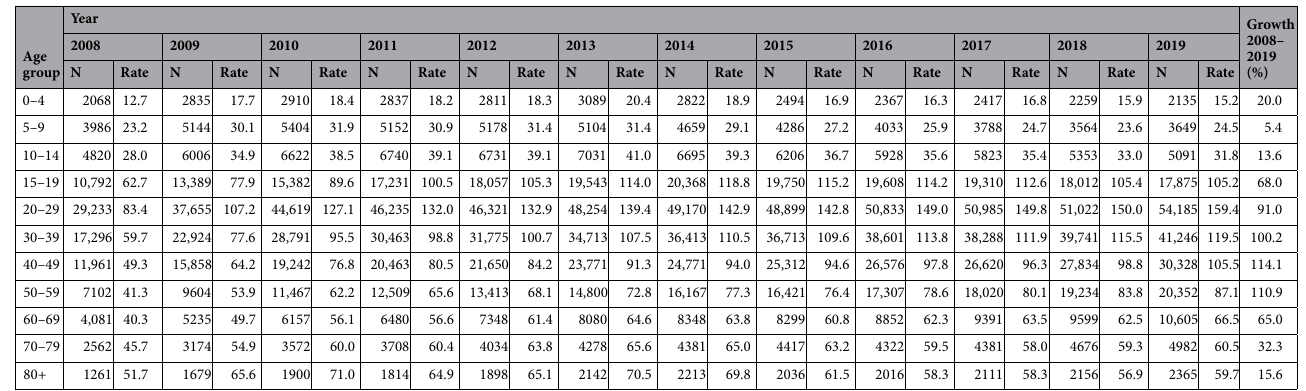
Table 2. Hospitalization rate for land transport accidents stratified by age group from 2008 to 2019, Brazil.